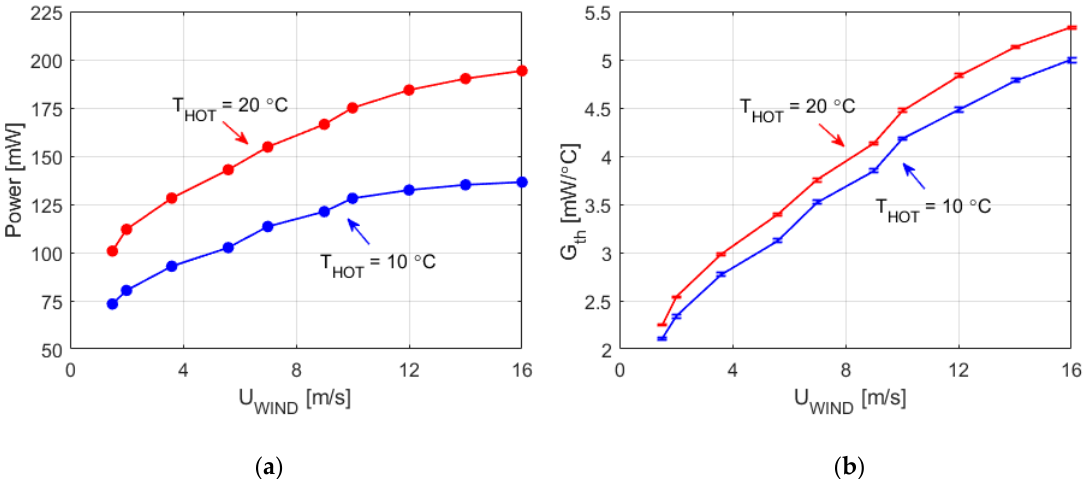
Figure 9. ( a ) Average values of the power injected in all sectors in the experiment of Figures 6 and 7; ( b ) average total convection heat transfer coefficient of the sphere, G th , during the same experiment, including the 1 σ error bars associated to the noise of the samples.